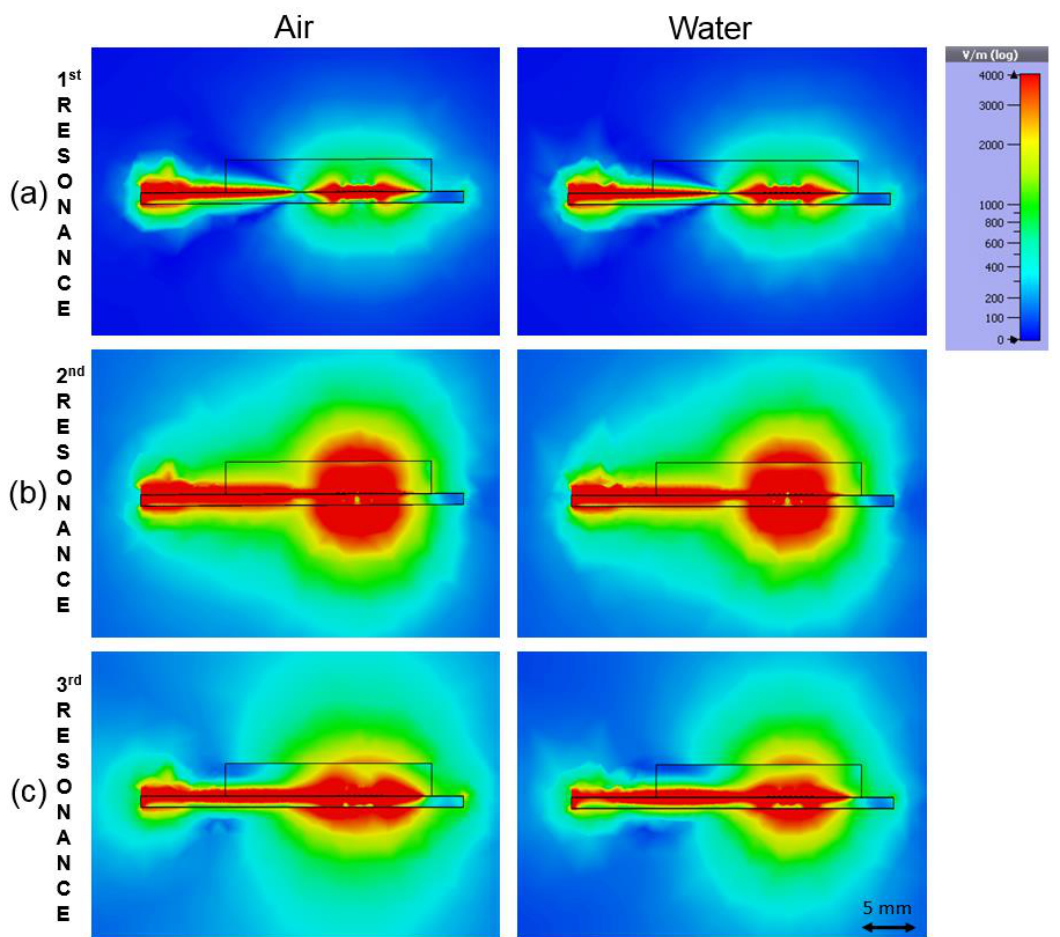
Figure 9. Simulated radiation patterns in three different resonances: ( a ) 1st resonance with air and with water; ( b ) 2nd resonance; ( c ) 3rd resonance where air shows higher radiation to surrounding space.